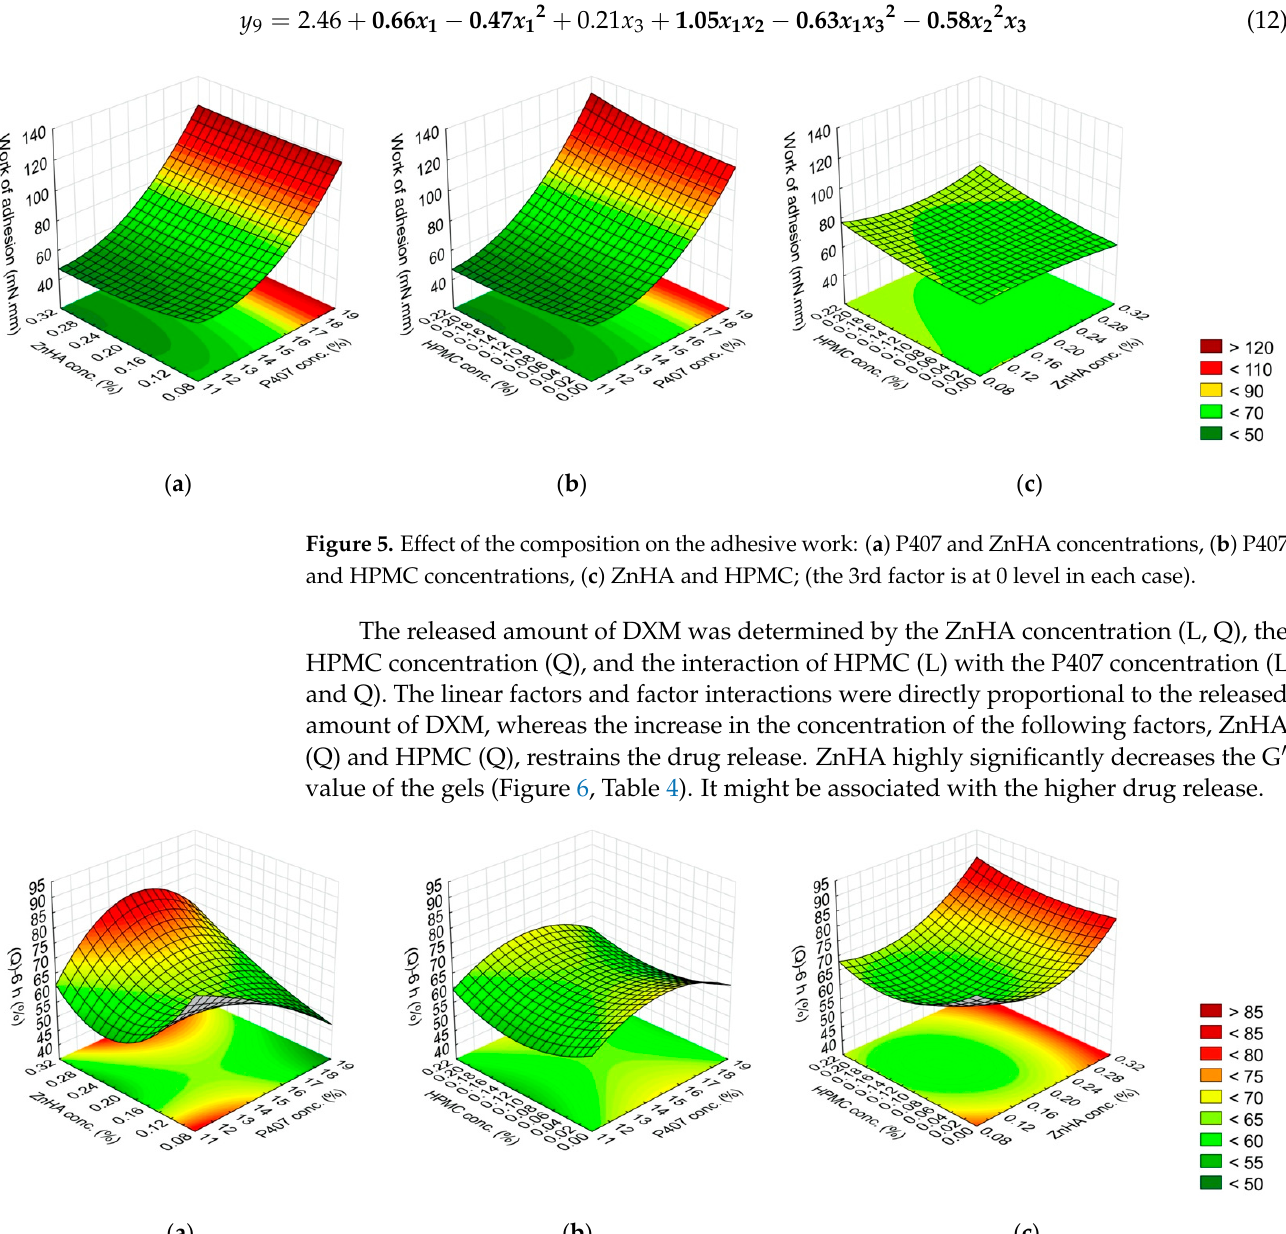
( c ) Figure 7. Effect of the composition on the IVRR: ( a ) P407 and ZnHA concentrations, ( b ) P407 and HPMC concentrations, ( c ) ZnHA and HPMC; (the 3rd factor is at 0 level in each case).